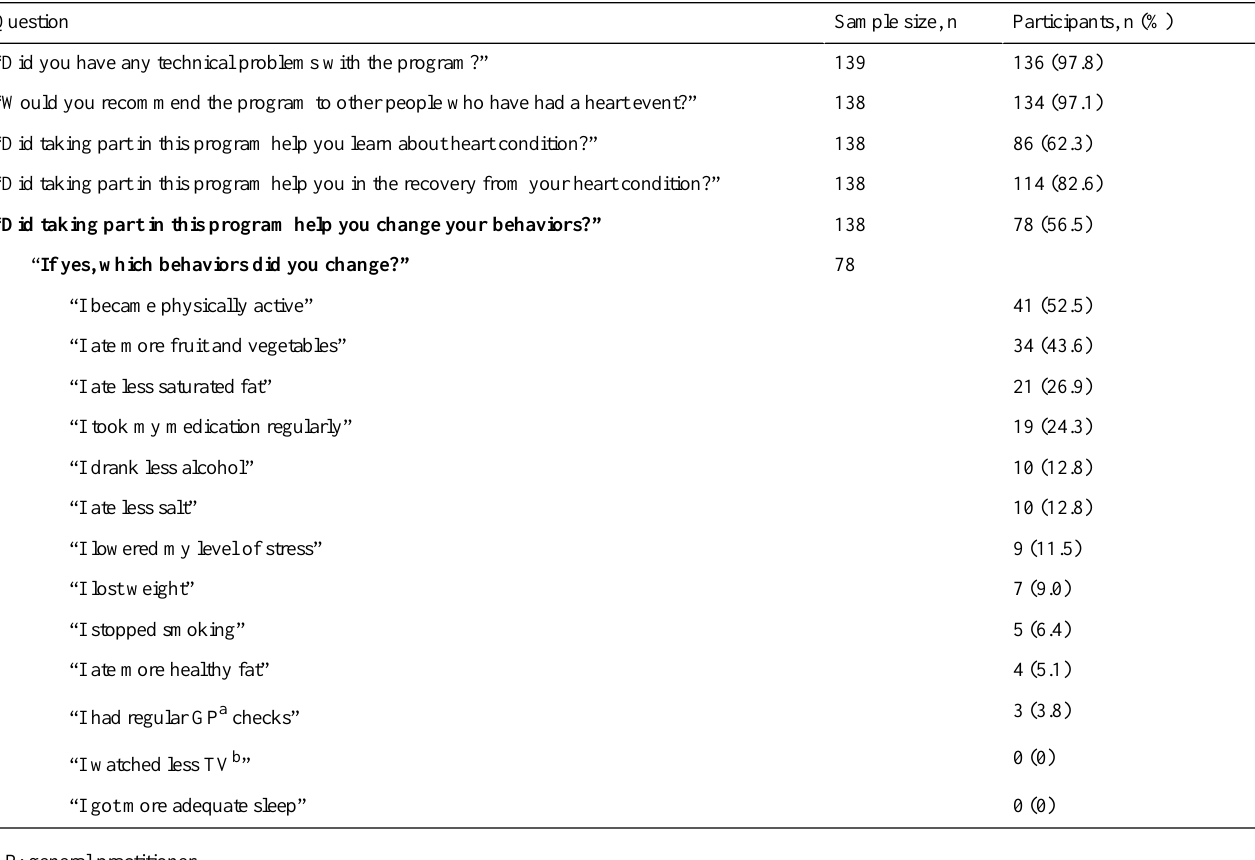
Table 4. Participants’responses on Text4HeartII